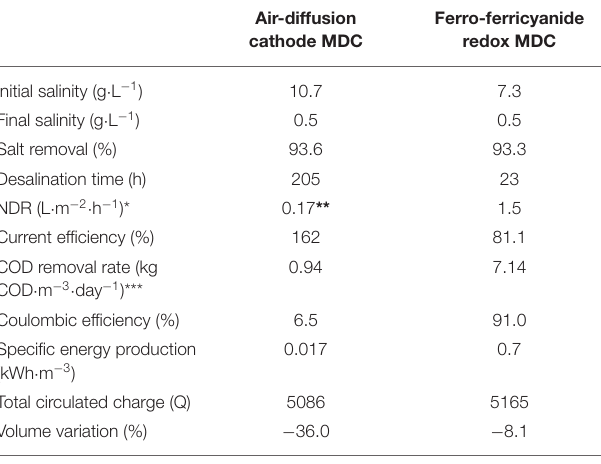
Figure 4B . For the air cathode MDC experiment, the